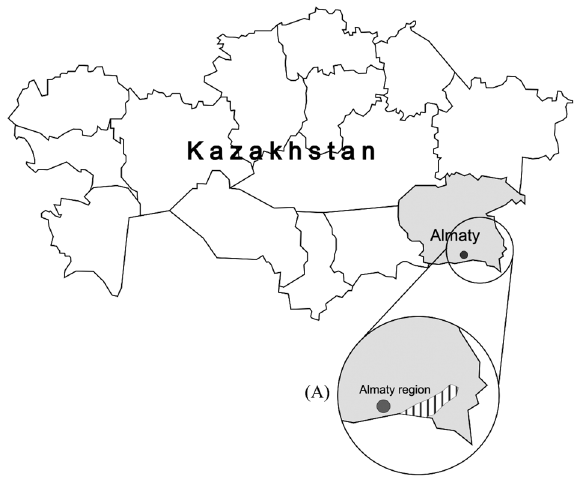
Figure 6. Kazakhstan with the Almaty region (shaded area on the map). A: Study region in southeastern Almaty (lined area on the inset). Map was created using CorelDraw 2017 (www. corel draw. com/ pl/? link= um) licensed by the University of